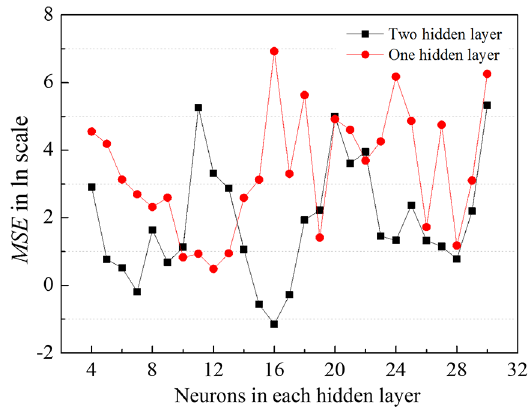
Figure 4. The mean square errors of single hidden layer and two hidden layers.